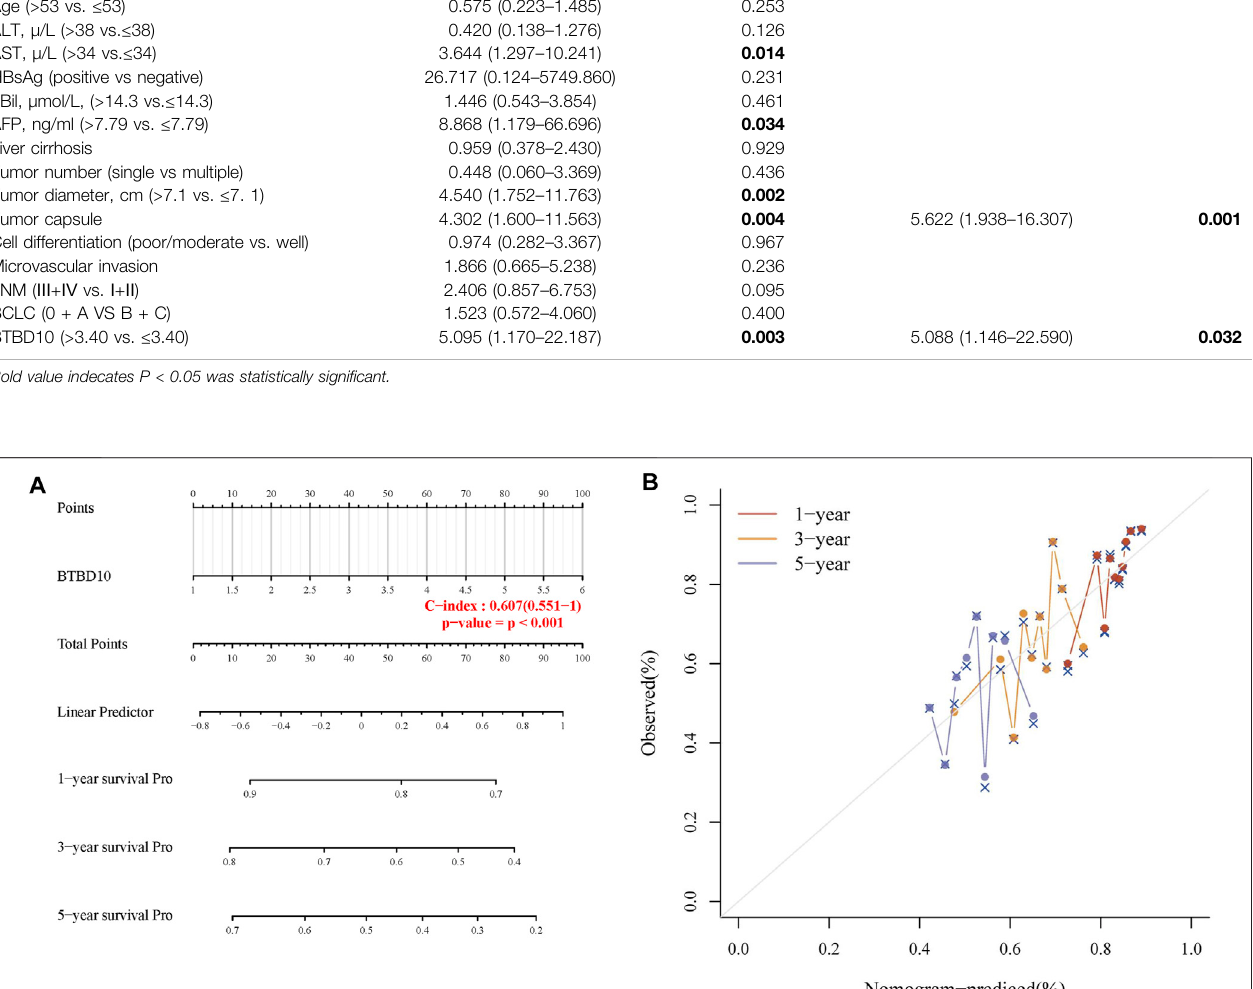
Frontiers in Molecular Biosciences |